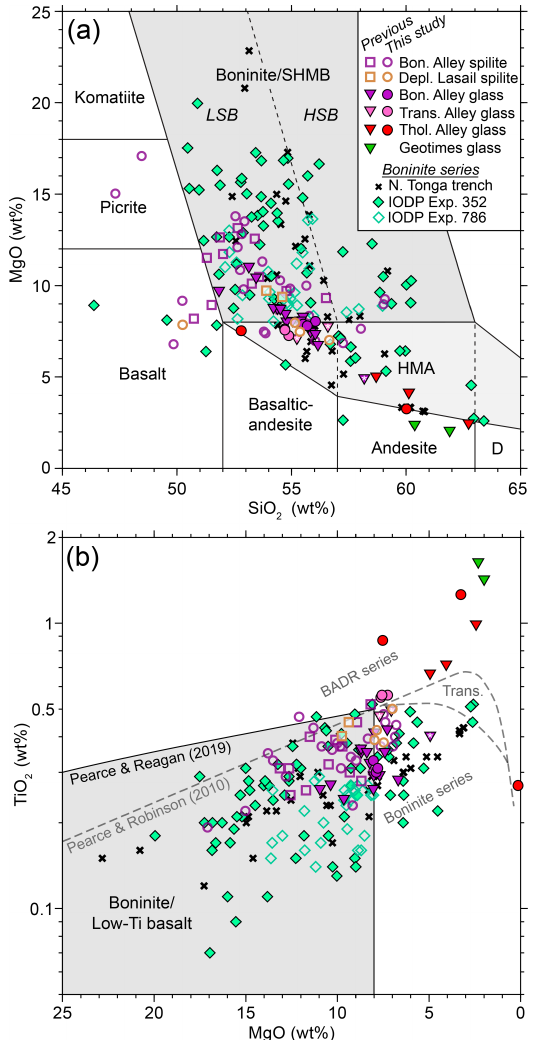
Figure 6. Boninite classification diagrams based on whole- rock major-element oxide concentrations normalised to 100wt%. (a) SiO 2 vs. MgO with rock fields after Pearce and Reagan (2019), SHMB meaning siliceous high-magnesium basalt, HMA meaning high-magnesium andesite, D meaning dacite. (b) MgO vs. TiO 2 with boninite/low-Ti basalt field adapted to log scale after Pearce and Reagan (2019), and original BADR–boninite series divider (dashed grey line) after Pearce and Robinson (2010). Filled circles: volcanic glasses (this study). Inverted triangles: volcanic glasses (Kusano et al., 2017). Unfilled circles: Boninitic Alley and De- pleted Lasail spilites (this study). Unfilled squares: Boninitic Alley and Depleted Lasail spilites (Belgrano and Diamond, 2019; Gilgen et al., 2014, 2016). West Pacific boninite analyses from the north Tonga Trench (Falloon et al., 2007; Falloon and Crawford, 1991), Izu–Bonin forearc (IODP Expedition 786; Murton et al., 1992), and Bonin forearc (IODP Expedition 352; Reagan et al.,